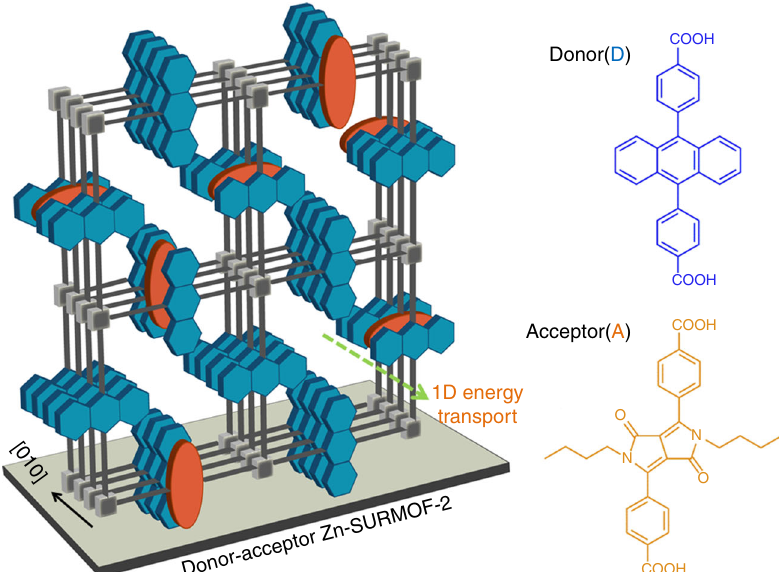
Fig. 1 Anisotropic architecture of a donor – acceptor SURMOF-2. A schematic of the fabricated Zn-SURMOF-2 structure: (left) a mixed-linker strategy to make mixed-linker donor – acceptor (DA) Zn-SURMOF-2, where the anthracene (blue) chromophores are stacked along [010] direction and the DPP (orange) linkers are homogeneously mixed in the stack. (Right) the individual linkers used to construct the mixed-linker donor – acceptor (DA) SURMOF-2; The blue and orange solids in the SURMOF-2 structure schematic represent ADB and DPP linkers, respectively; gray fi lled cubes represent the Zn-paddle- wheel secondary building